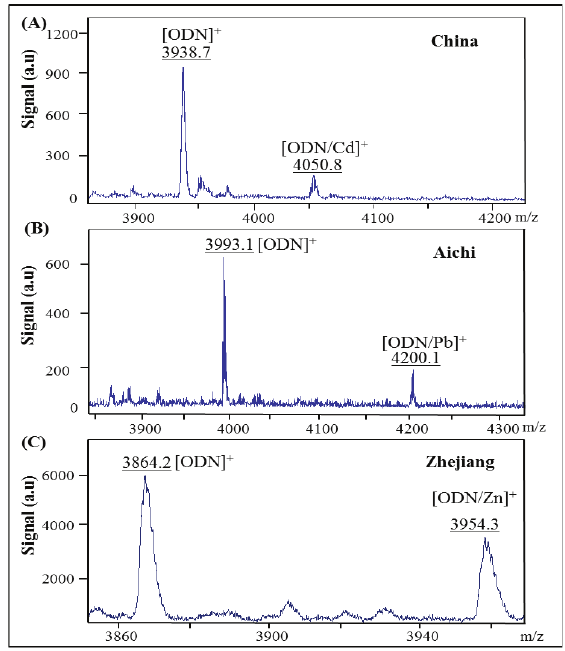
Figure 2. MALDI-TOF/TOF mass spectra of oligonucleotide (ODN) derived from H5N1 gene for neuraminidase labeled with QDs (CdS, PbS and ZnS). ( A ) Spectra of ODN and ODN labeled with CdS in China H5N1 sequence; ( B ) spectra of ODN and ODN labeled with PbS in Aichi H5N1 sequence; and ( C ) spectra of ODN and ODN labeled with ZnS in Zhejiang H5N1 influenza virus. 3-hydroxypicolinic acid (3-HPA) and diammonium citrate were used as